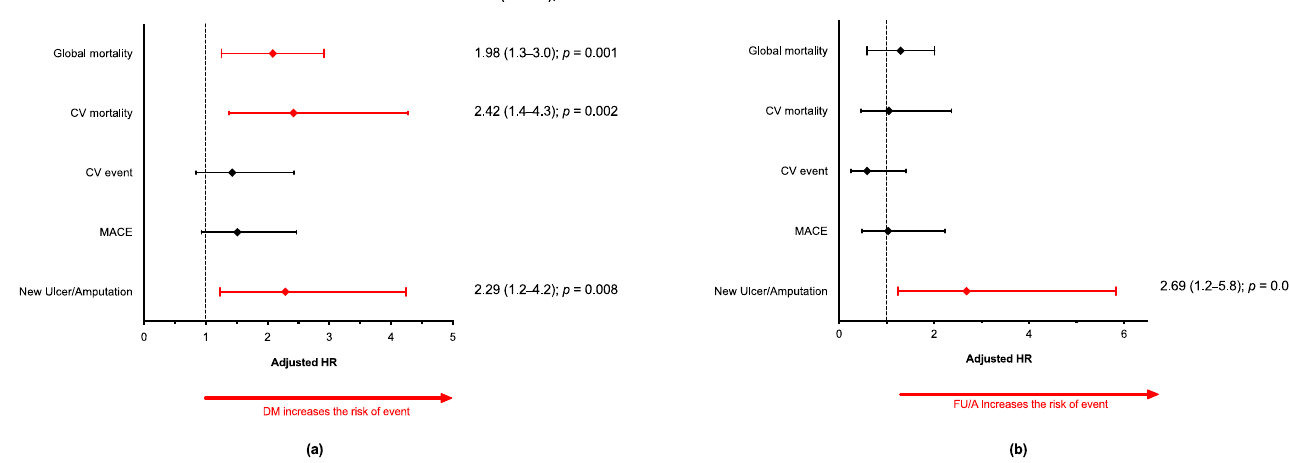
Figure 2. Adjusted hazard ratios for each of the studied outcomes based on the presence of diabetes mellitus ( a ) and on the presence or absence of previous diabetic foot ( b ). CV, cardiovascular; HR, hazard ratio; MACE, major adverse cardio- vascular event.